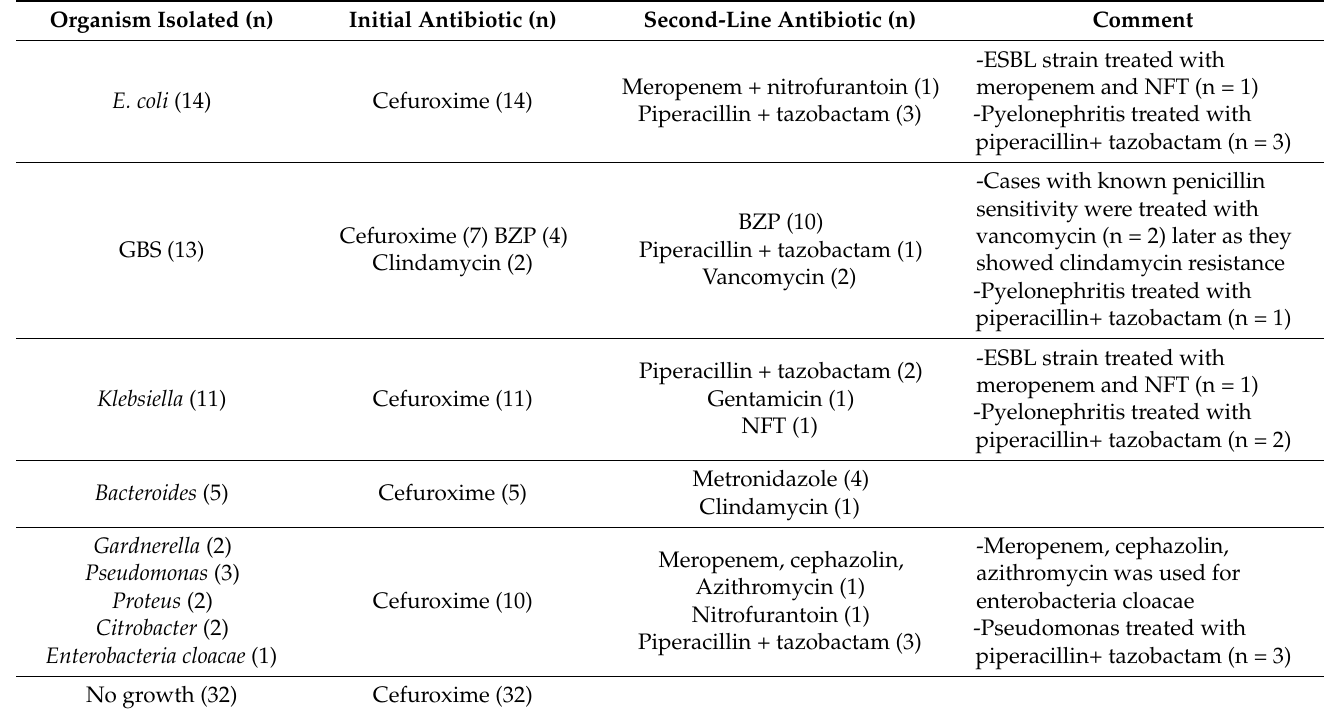
Table 3. Culture isolates and antibiotic